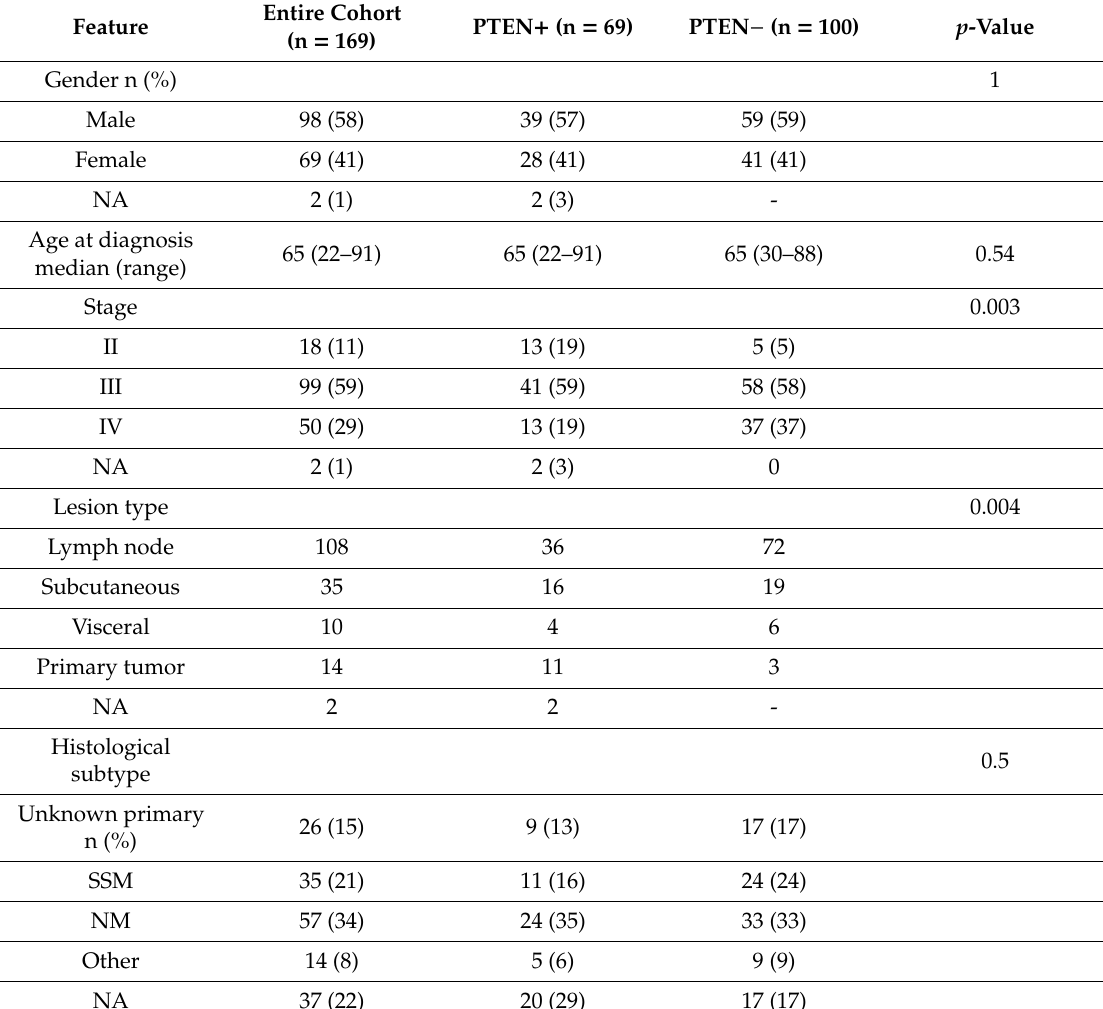
Table 1. Clinical features of the 169 melanoma cases in correlation with PTEN status. p -values from Fisher’s exact test, not adjusted for multiple